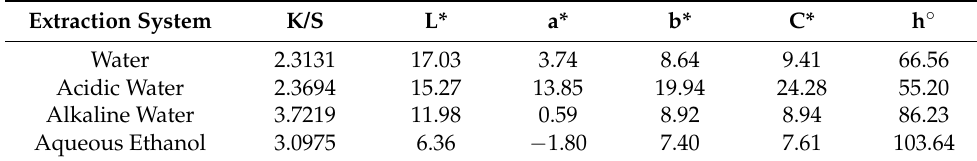
Figure 2. Extracted trial solutions; ( a ) water, ( b ) water/HCl, ( c ) water/NaOH and ( d ) EtOH. The color coordinates of the extracted solutions were measured by using Datacolor 650. Results are presented in Table 2. Table 2. Color coordinates of extracted